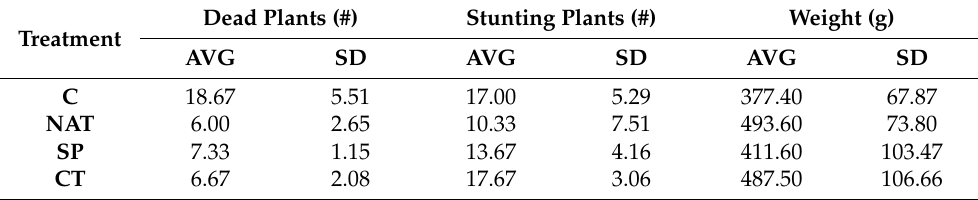
Figure 2. Examples of experimental plots of Lactuca sativa organic fertilization tests: Control (C) irrigated only with water and showing higher occurrence of Fusarium oxysporum attack. Treatments by foliar application with water with added spirulina (SP), spirulina after natural uptake of F. oxysporum DNA (NAT), and commercial compost tea (CT). Table 1. Number of plants either dead or with reduced growth because of Fusarium oxysporum infection and weight of individuals in control plots (C) and in different foliar application treatments with compost tea (CT), spirulina (SP), and spirulina previously exposed to natural uptake of Fusarium DNA (NAT). Weight data are averages of random 10 plants and corresponding standard deviations.